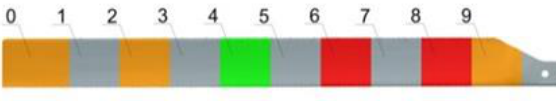
Fig. 8. Blade division into calculation sections